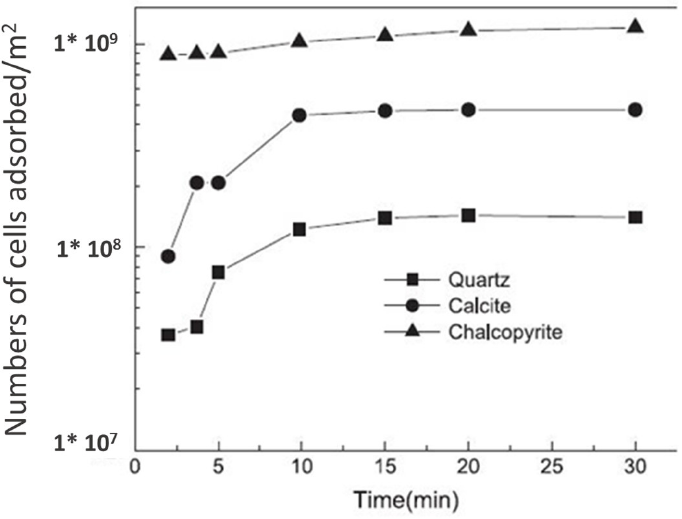
Figure 9. Adsorption density of Bacillus polymyxa cells in quartz, calcite and chalcopyrite as a func- tion of time [27].